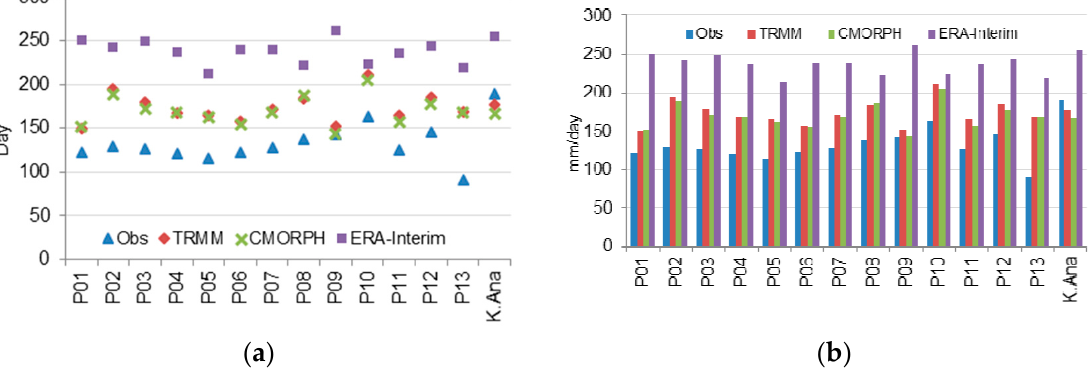
Figure 2. ( a ) Comparison of average number of rainy days per year of different Satellite-Based and Reanalysis Precipitation (SBRP) and Ground Measured Precipitation (GMP) data sets; ( b ) The ability of SBRP in capturing the average maximum daily rainfall.